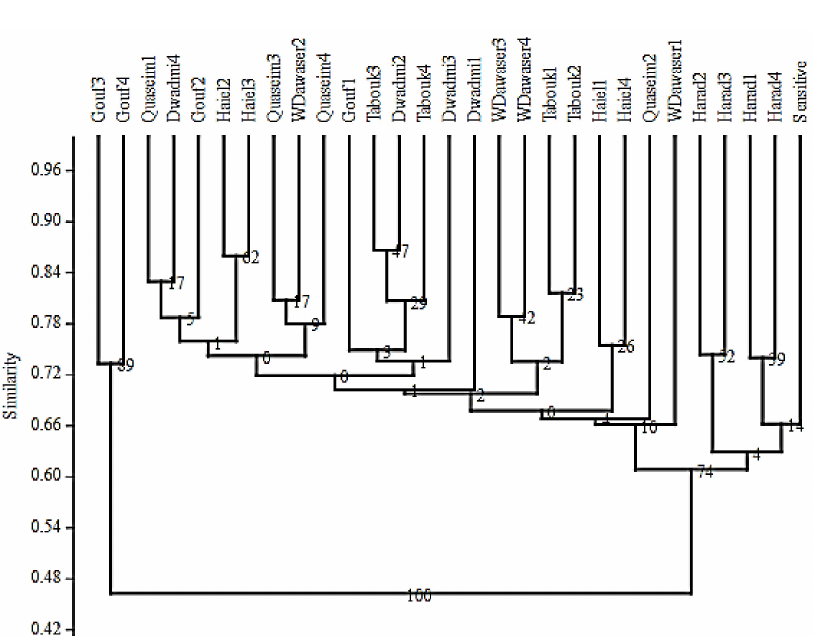
Figure 4. Dendrogram explaining the genetic relationships among Lolium genotypes based on the data of 31 (SSR)